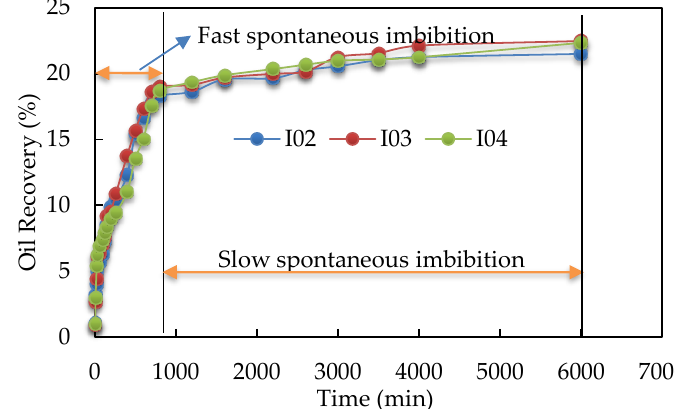
Figure 11. Oil recovery from spontaneous imbibition.